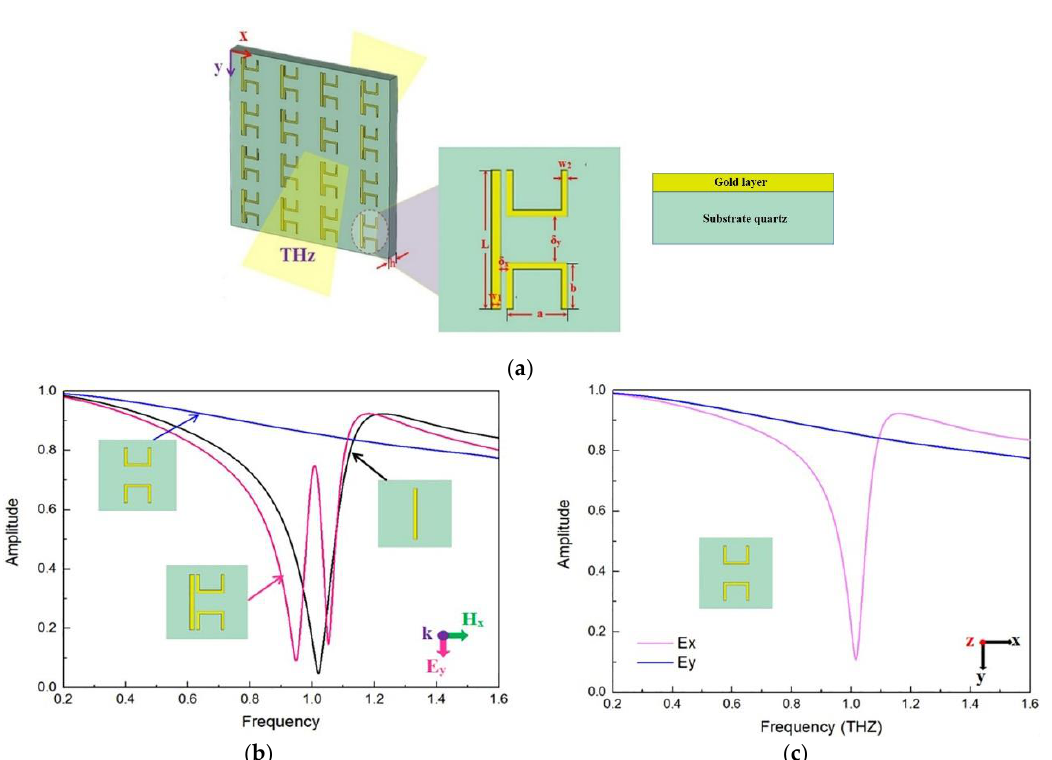
Figure 1. The transmission properties of metamaterials based on different symmetrical structures. ( a ) Schematic diagram of metamaterial structure; ( b ) The transmission spectra of CW (black), USRs (blue), and CW+USRs array (red) in the direction of E y electric field. The CW resonator shows typical LSP resonance at 1.01 THz, while an electromagnetically induced transparency-like window can be found in the CW + USRs structure; ( c ) The transmission spectra of USR array in the direction of E x and E y electric fields, the horizontal orientation of the incident electric field can excite the LC resonance of USRs at similar